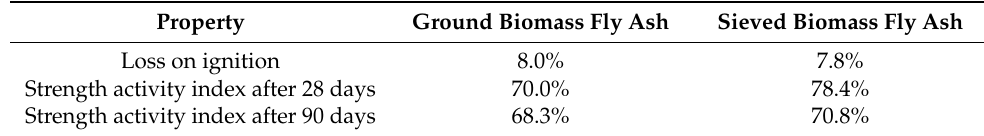
Table 7. Physical Properties of Activated Biomass Fly Ash.